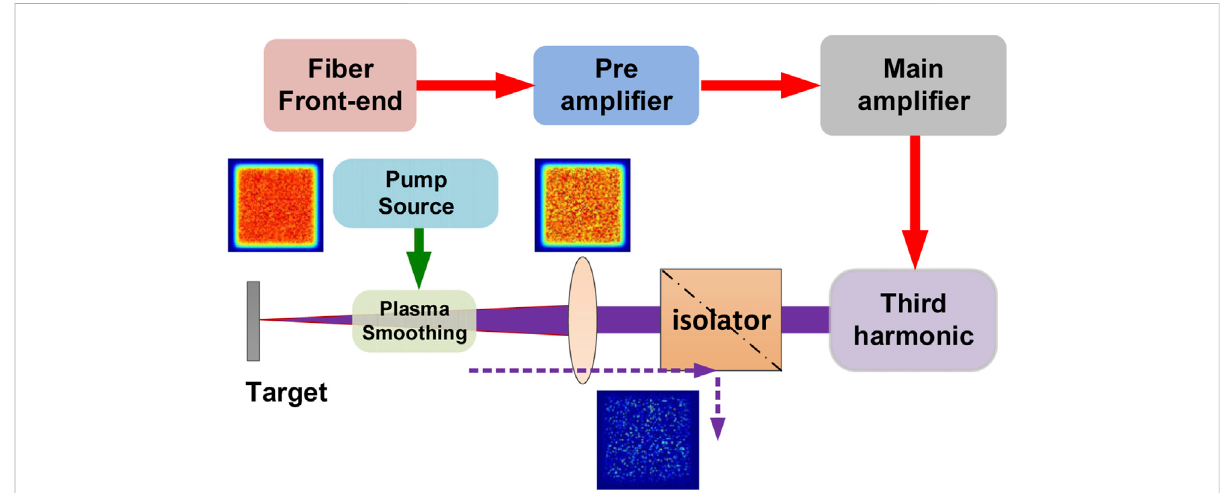
FIGURE 1 Schematic of simulated Brillouin scattering in plasma for beam smoothing.